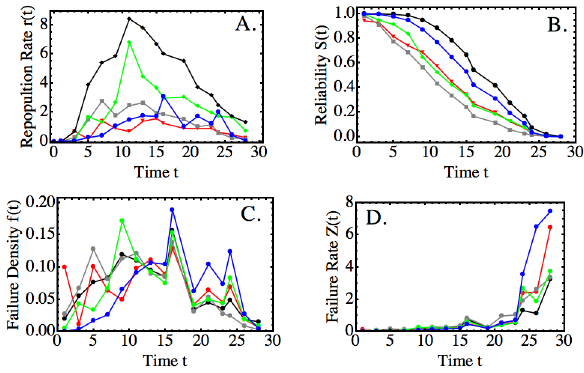
Figure 3. Reliability and Failure Kinetics of a Long-lived Long- term Repopulating HSC. A–D: Four types of kinetics were calculated (compare Algorithm 1) from experimental kinetics for all clonal cell populations together (black), and the myeloid (green), T lymphocyte (red), and B lymphocyte (gray) cell populations, separately. In the representative example shown, notation is as in Algorithm 1 (applied to a single kinetic, i.e. batch size M ~ 1 ). Also shown are the respective kinetics for the population of clonal hematopoietic stem cells (HSCs; blue). Since population data are difficult to obtain for stem cells directly, the HSC-related kinetics were inferred from the other data. This was accomplished by first predicting the reliability (Part B, blue curve) using the structure balance eq 1 and, then, deriving the other kinetics (blue curves for C, D, then A) with the methods of Algorithm 1.